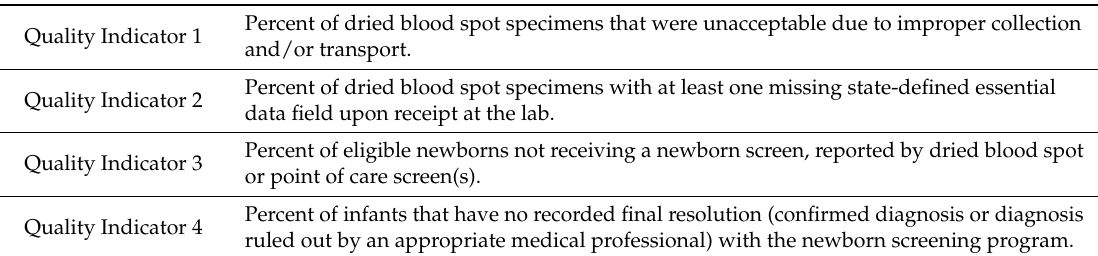
Table 5. Newborn Screening Quality Indicators